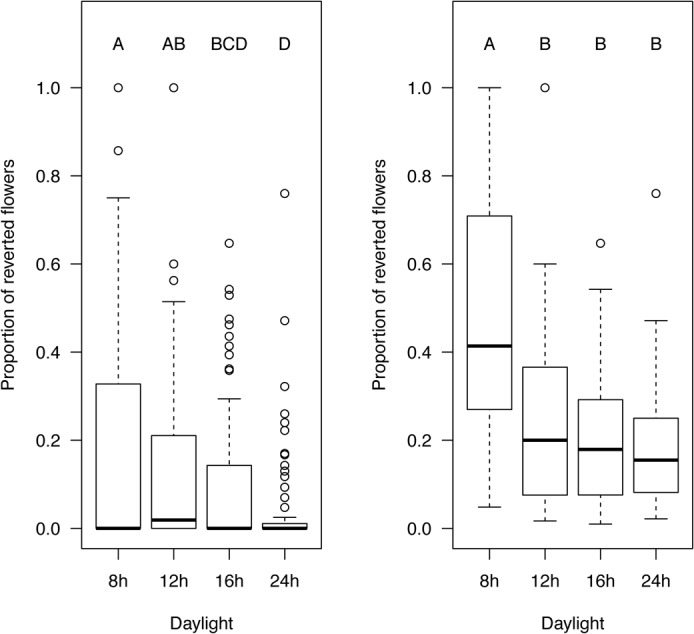
Floral reversion frequency increases in short days.Individuals from each population were grown in incubators (20°C; and day lengths set at 8h light/16h dark; 12h light/12h dark; 16h light/8h dark; 24h light) until senescence. Reverting flowers were counted along the inflorescence axis from the first (oldest) to the 80th flower position and the proportion of total reverting flowers was calculated for each condition. Here, data from all eleven populations were analyzed together. The plot on the left includes data from all plants from the study, the plot on the right excludes plants that exhibited no case of floral reversion. Statistically significant differences in reversion rates between treatments were determined using ANOVA and Tukey posthoc testing. Treatments not connected by a letter are statistically significantly different from each other (p< 0.05). Boxplots show data range, including median (bold line), the 25th, 75th, and 5th or 95th percentile of data distribution (lower and upper end of box, and lower and upper whiskers, respectively), plus outliers (circles). N = 148 (reverting), 190 (never reverting).